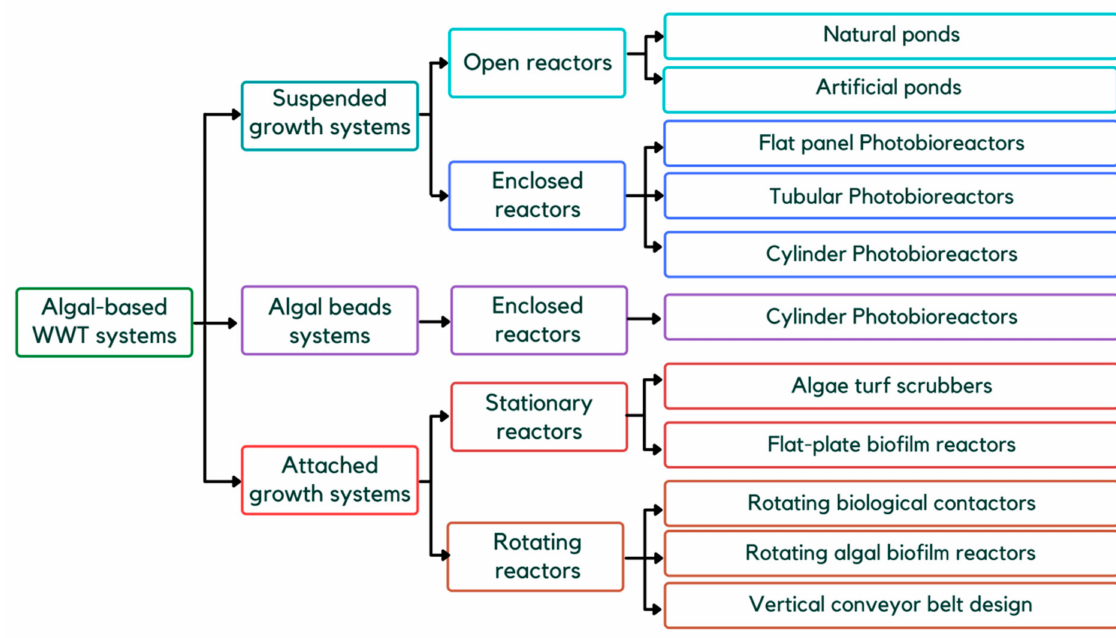
Figure 2. Tree diagram of the most commonly used algae-based wastewater treatment reactor